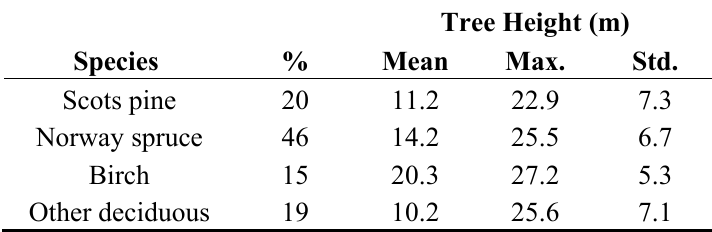
Table 2. Reference data tree species distribution and heights.